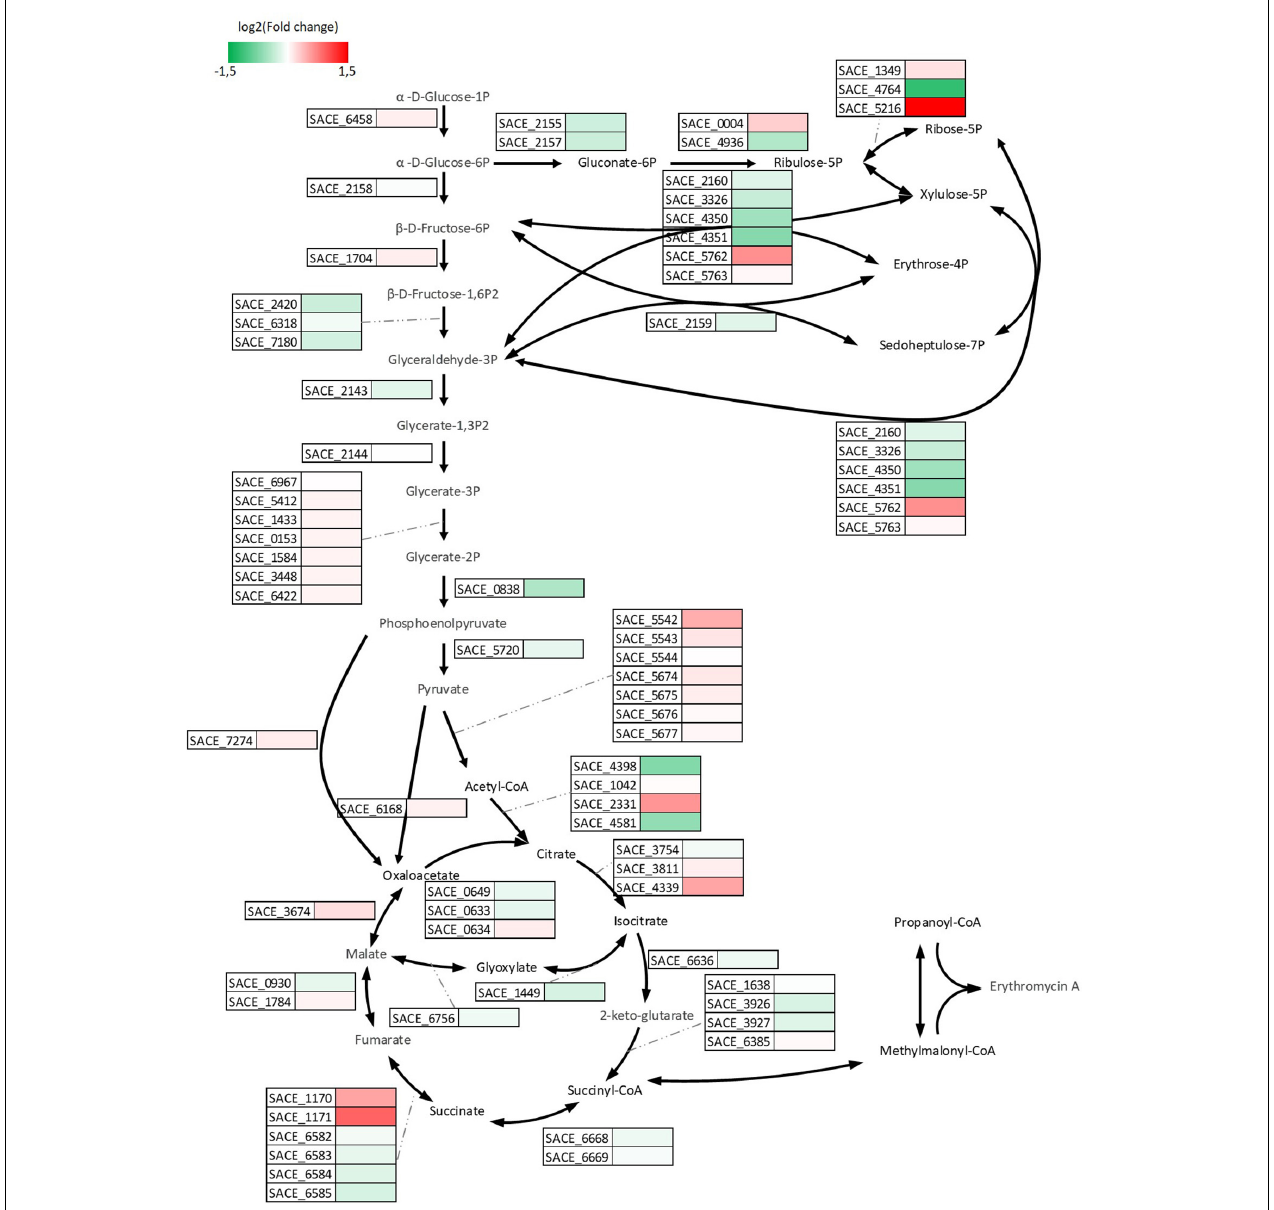
FIGURE 7 | Visualization of differences in central carbon metabolism at transcription level. Rectangular with color beside the black arrows represent the relative transcription level of genes responsible for the reactions in A2N compared to E3.